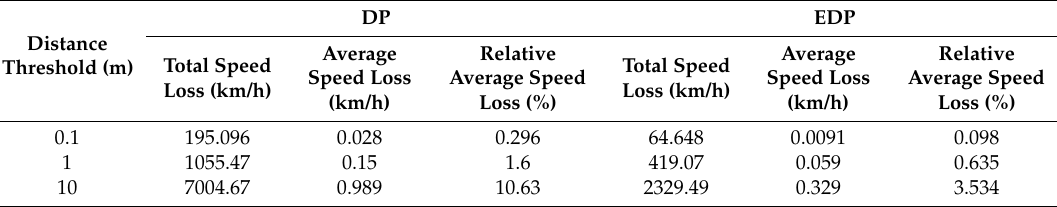
Table A2. Speed loss of DP and EDP simplification with different distance